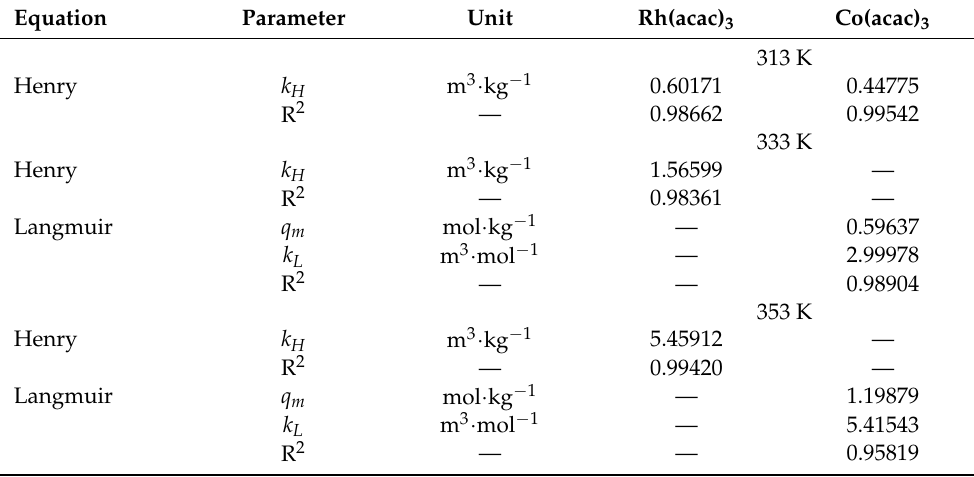
Figure A20. Uptake of different precursors on MCM-41 at 15 MPa and different temperatures; experimental data taken from [60,62]. Table A20. Adsorption isotherm parameters of different precursors from scCO 2 solution on MCM-41 at 15 MPa and different temperatures [60,62].